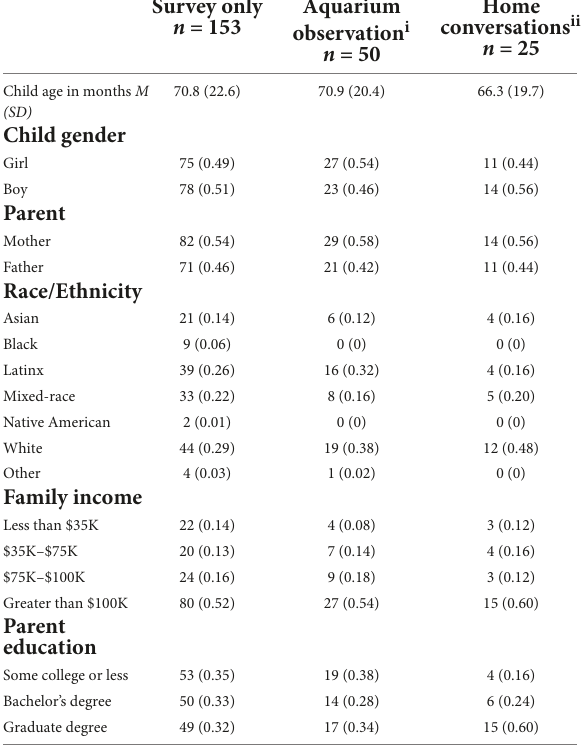
TABLE 1 Descriptive statistics for child, parent, and family demographic